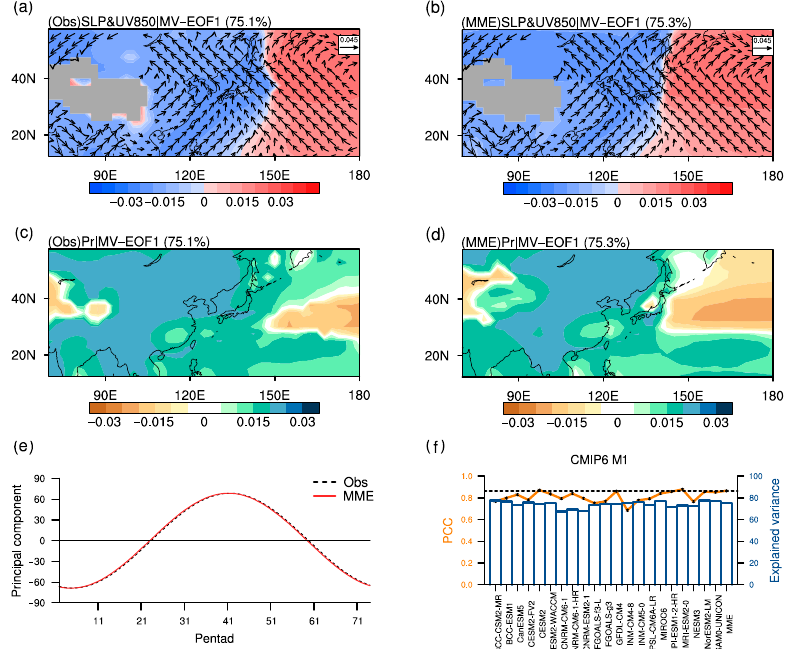
Figure 4. First annual cycle mode (M1) of EA precipitation from MV-EOF1 in ( a , c ) OBS and ( b , d ) MME. ( a , b ) show the spatial structures for the SLP and 850-hPa horizontal wind anomalies and ( c , d ) for precipitation anomalies. The explained variance of M1 is 75.1% in observation and 75.3% in MME simulation. ( e ) Principal component (PC) time series of MV-EOF1. The horizontal axis ranges from Julian pentad 1 to 73. The black trigonometric function curve indicates the observation, and the red one indicates the MME mean. The amplitude and phase of the PC1 series are adopted as the amplitude ( A pc 1 ) and phase ( ϕ pc 1 ) of M1. ( f ) Explained variances (blue bar) of MV-EOF1 in individual models and the MME mean. The MV-EOF is applied on the MME and individual models, respectively. The orange curve indicates the multivariate pattern correlation coefficients between the MV-EOF1 spatial pattern in OBS ( a , c ) and models (such as ( b , d ) for MME). The black dashed line indicates the MME